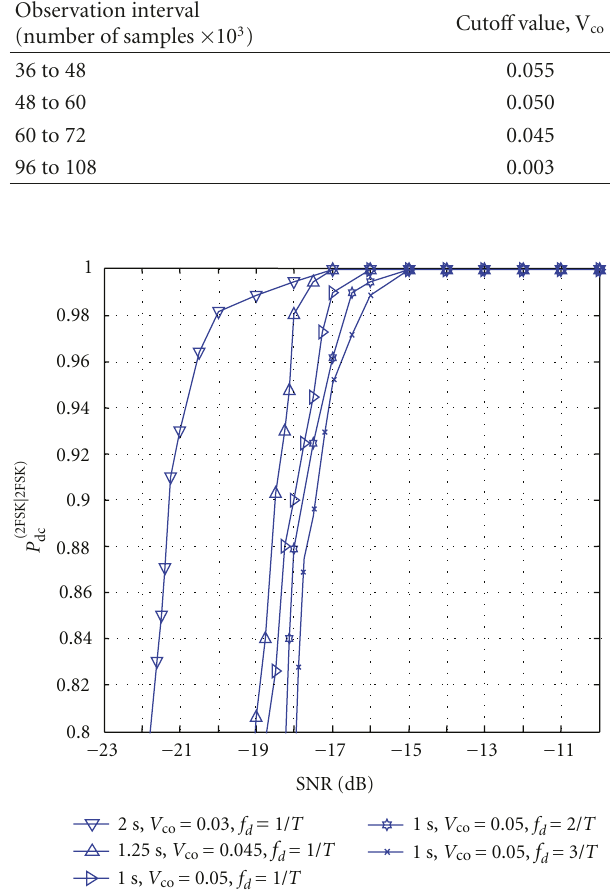
Figure 6: The probability of detection and correct signal classifica- tion, P (2FSK | 2FSK) , versus SNR, for several observation intervals and dc frequency